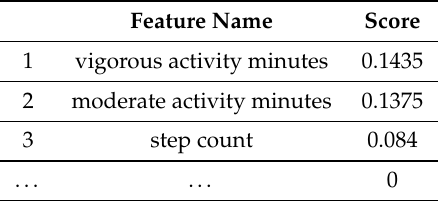
Table 3. Information gain feature